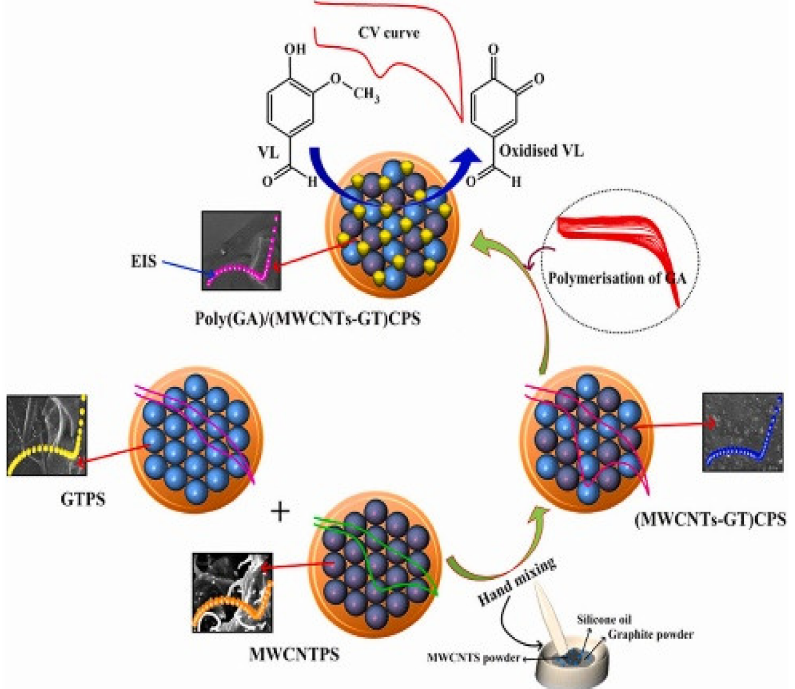
Figure 3. Graphical representation of the whole experiment. Reprinted (adapted) with permission from Ref. [47]. Copyright 2021, Springer